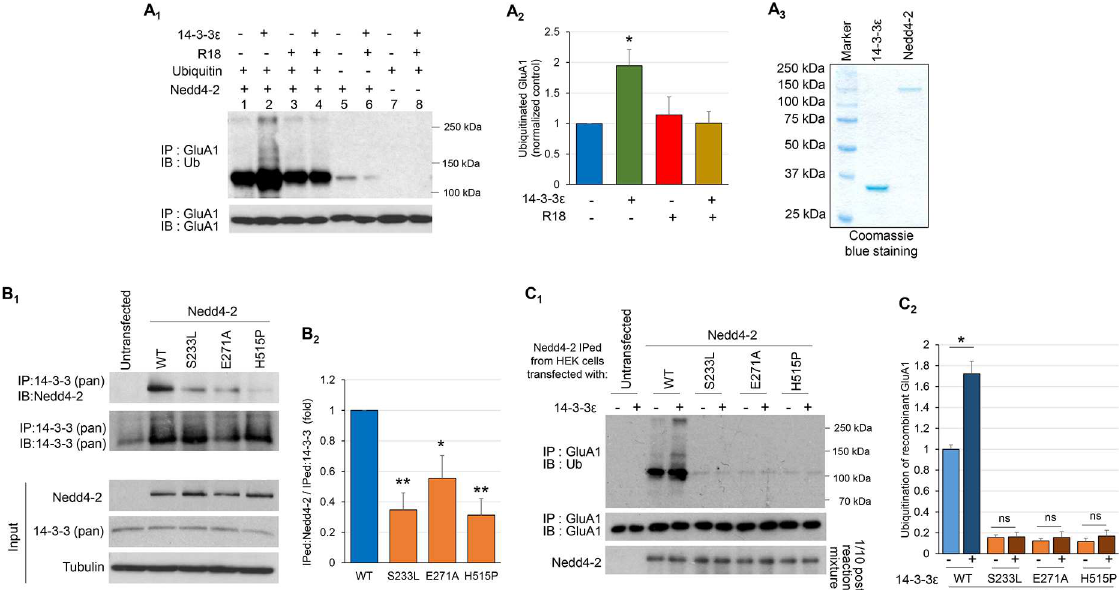
Fig 7. Three epilepsy-associatedmissense mutations of Nedd4-2 disrupt 14-3-3-facilitated GluA1 ubiquitination. ( A 1 ) Western blots of Ub or GluA1 after immunoprecipitation with anti-GluA1 antibodyfollowing in vitro ubiquitination with recombinant GluA1 and Nedd4-2, and in the presenceor absenceof recombinant 14-3-3 ε ,14-3-3 inhibitor R18, or Ubiquitinas labeled. Quantification of lanes 1–4 by the entire area of smear from 100–250 kDa ( A 2 ) and Coomassie blue stainingshowingthe purity of recombinant Nedd4-2and 14-3-3 ε ( A 3 ) (n = 4, 2-way ANOVA with post-hoc Tukey test). ( B 1 ) Western blots of Nedd4-2or 14-3-3 after a co-immunoprecipitation using anti-14-3-3antibody with the lysate of HEK cells transfected with HA-taggedWT or mutant Nedd4-2s for 48 hours. Input of transfected Nedd4-2s, endogenous 14-3-3, and Tubulin are shown on the bottom. Quantificationof immunoprecipitatedNedd4-2( B 2 ) is shown on the right (n = 4, one-wayANOVA with post-hoc Tukey test). ( C 1 ) Western blots of Ub or GluA1 after immunoprecipitationwith anti-GluA1 antibody following in vitro ubiquitination with recombinant GluA1 in the presenceor absenceof recombinant 14-3-3 ε .HA-tagged WT or mutant Nedd4-2s used for in vitro ubiquitination were obtained from HEK cells transfected with one of the Nedd4-2s followedby immunoprecipitation with anti-Nedd4-2 antibody.Right before the washing,1/10 of reaction mixture was obtainedand used as input control shown on the bottom. ( C 2 ) The intensity of ubiquitinated GluA1 by the entire area of smear from 100–250kDa is normalized to the WT group in the absenceof 14-3-3 ε (lane 3 on the representative blot C 1 ). The difference in each group with or without the additionof 14-3-3 ε was analyzedby Student’s t -test. For all experiments, data are representedas mean ± SEM with * p < 0.05, ** p <